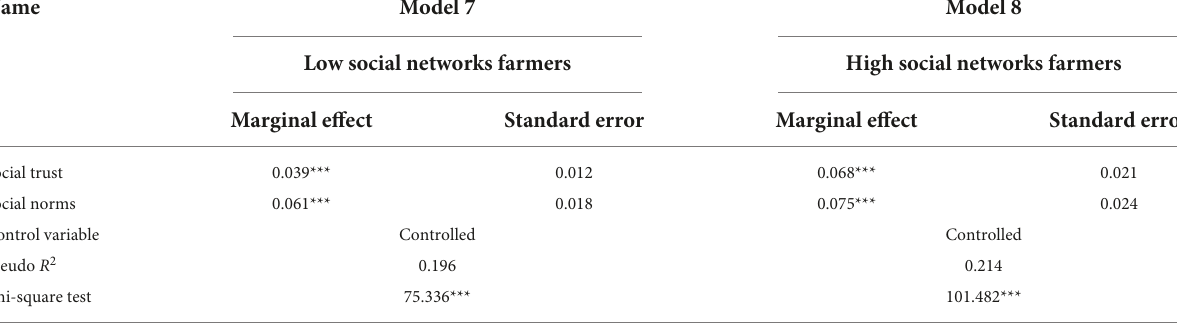
TABLE 8 Estimated results of the impact of social capital on farmers’ green control technology (GCT) adoption behavior (group regression